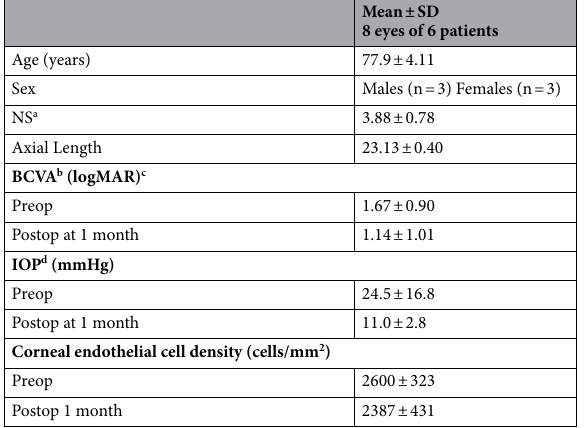
Table 1. The characteristics of participants and postoperative outcomes. a NS: Nuclear Sclerosis. b BCVA: best- corrected visual acuity. c logMAR: logarithm of the minimum angle of resolution. d IOP: intraocular pressure.